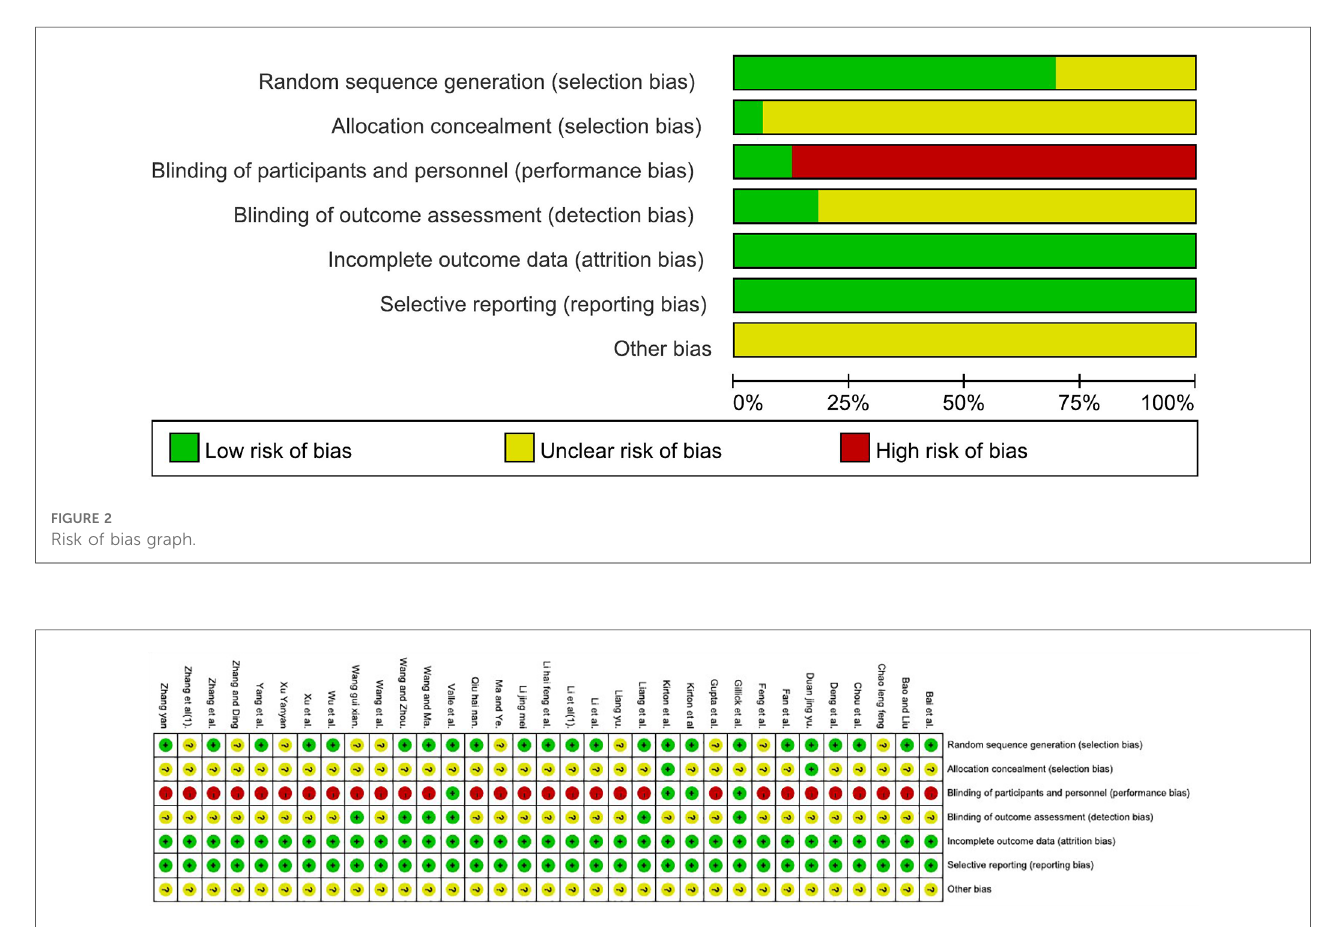
FIGURE 3 Risk of bias